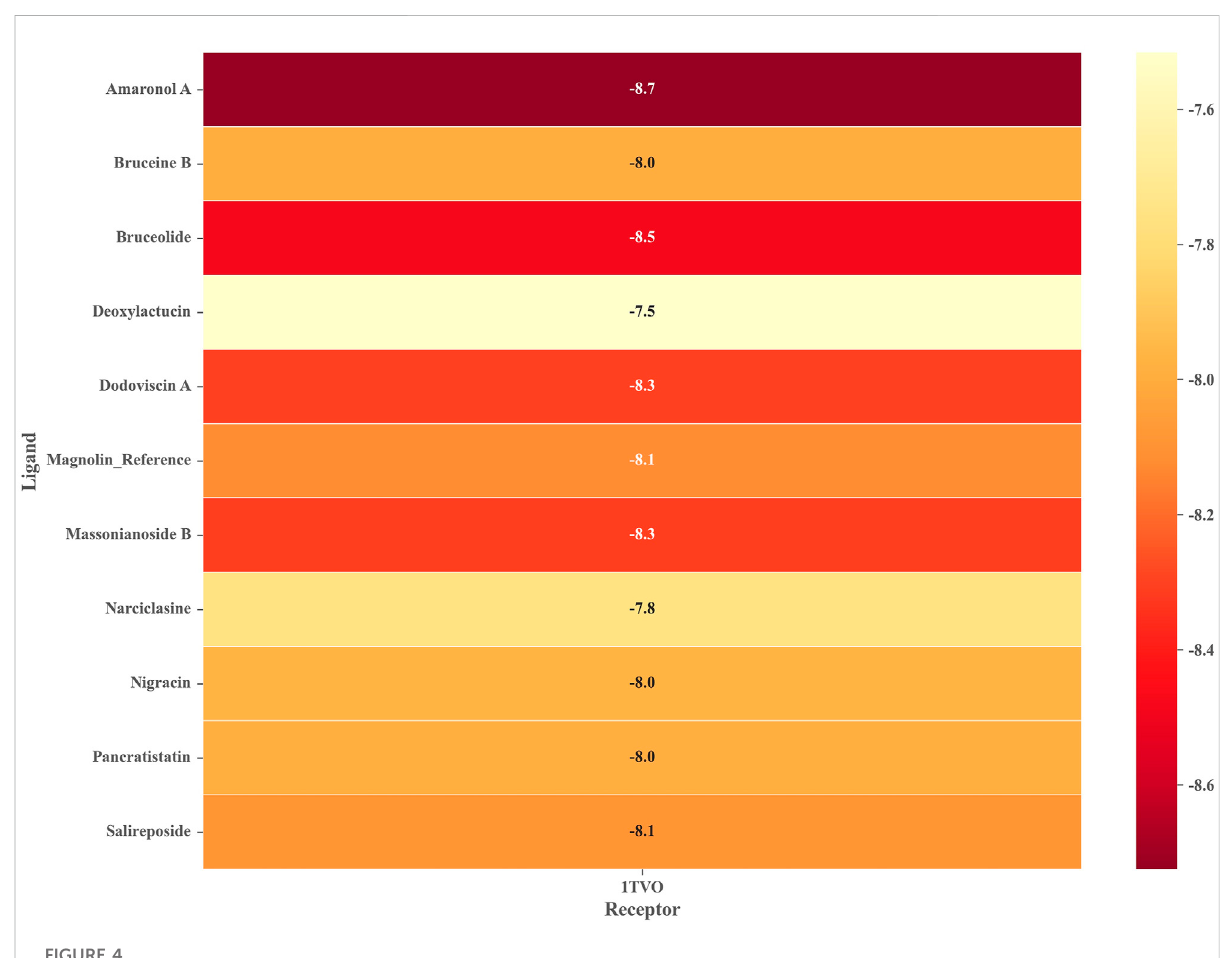
FIGURE 4 Binding free energy of 10 candidate compounds to ERK2 (PDB ID: